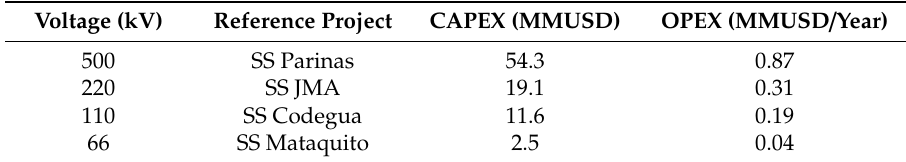
Table 4. CAPEX and OPEX for the substation according to the voltage level of the line to be connected